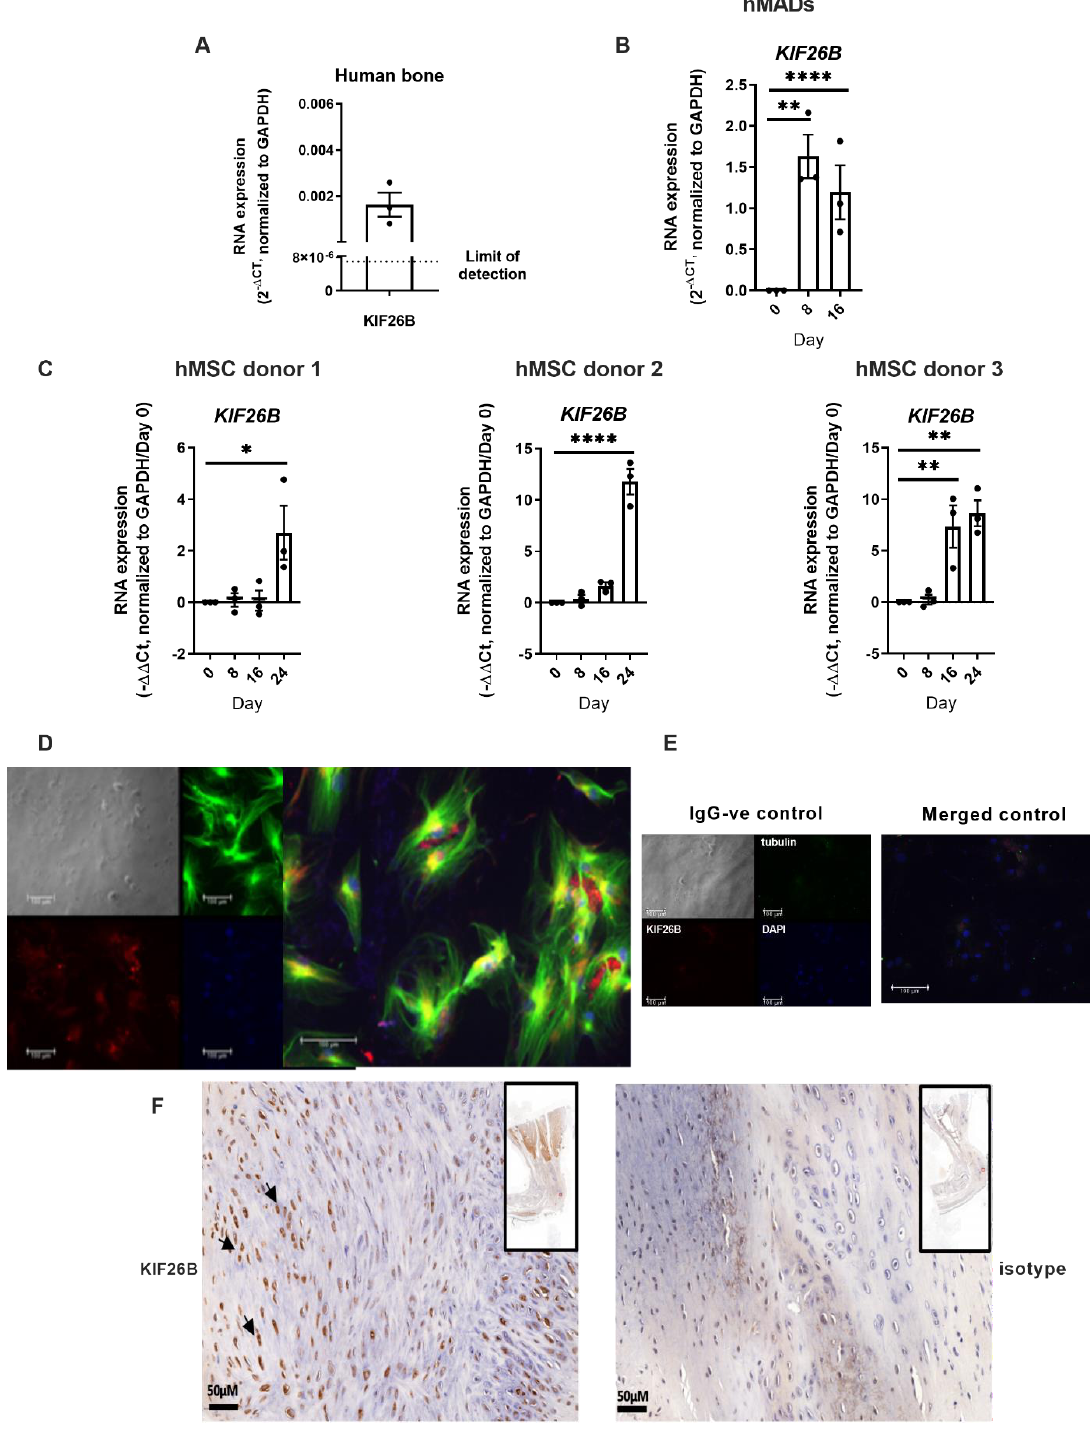
Figure 2. KIF26B is expressed in human bone and is induced in mesenchymal stem cells by BMP2 in vitro and in mammalian models of developing HO tissue. ( A ) RT-qPCR was used to measure the expression of KIF26B RNA in waste bone samples retrieved at joint replacement (n = 3 subjects). ( B ) KIF26B expression is induced in human multipotent adipose-derived stem cells (hMADs). RT-qPCR was used to measure the expression of KIF26B in hMADS at days 0, 8 and 16 of hMAD differentiation. Data were analyzed using 2 (−ΔCt) by normalizing to GAPDH (n = 3 biological replicates). Analyses were